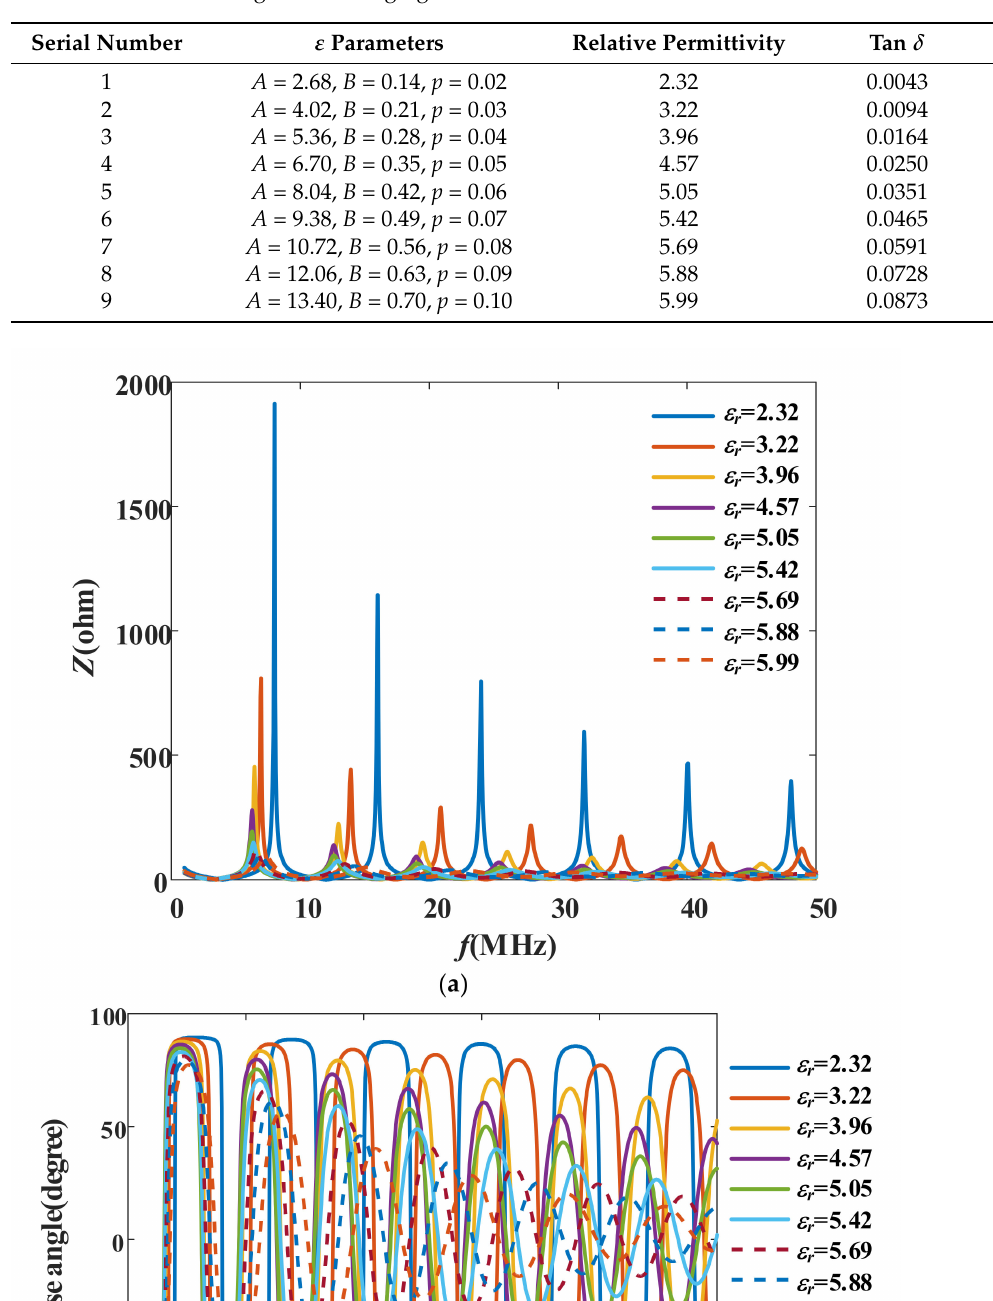
Table 3. The different degrees of the aging.